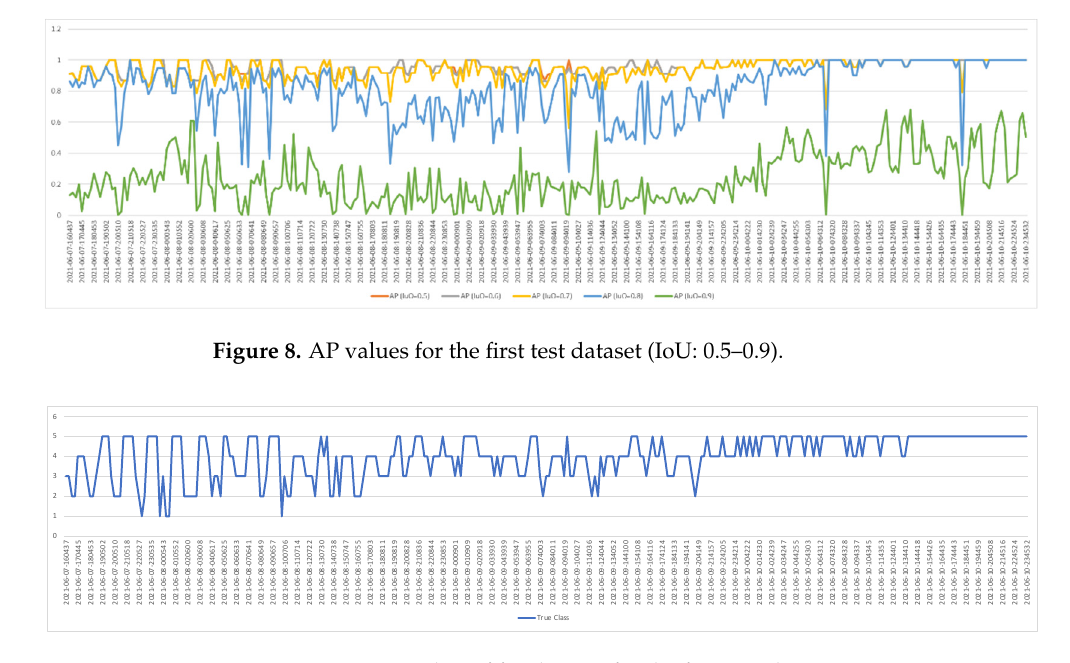
Figure 9. Correct number of fertile eggs for the first test dataset. Figure 10. AP values for the second test dataset (IoU: 0.5–0.9).